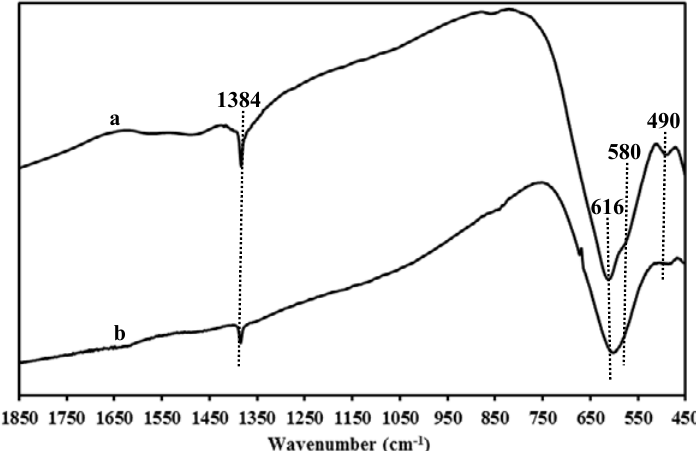
Fig. 1. The infrared spectrum of the prepared crystalline LaMnO